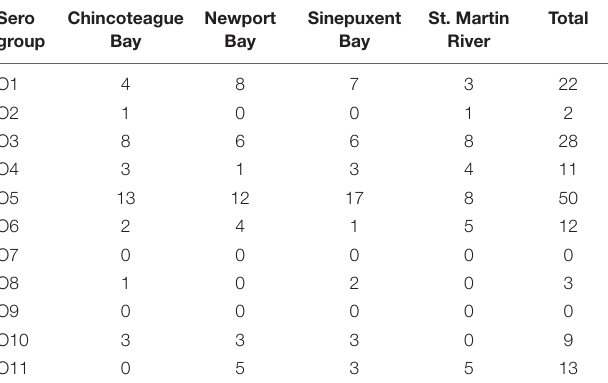
TABLE 1 | Distribution of Vibrio parahaemolyticus O serogroups in four sites of Maryland Coastal